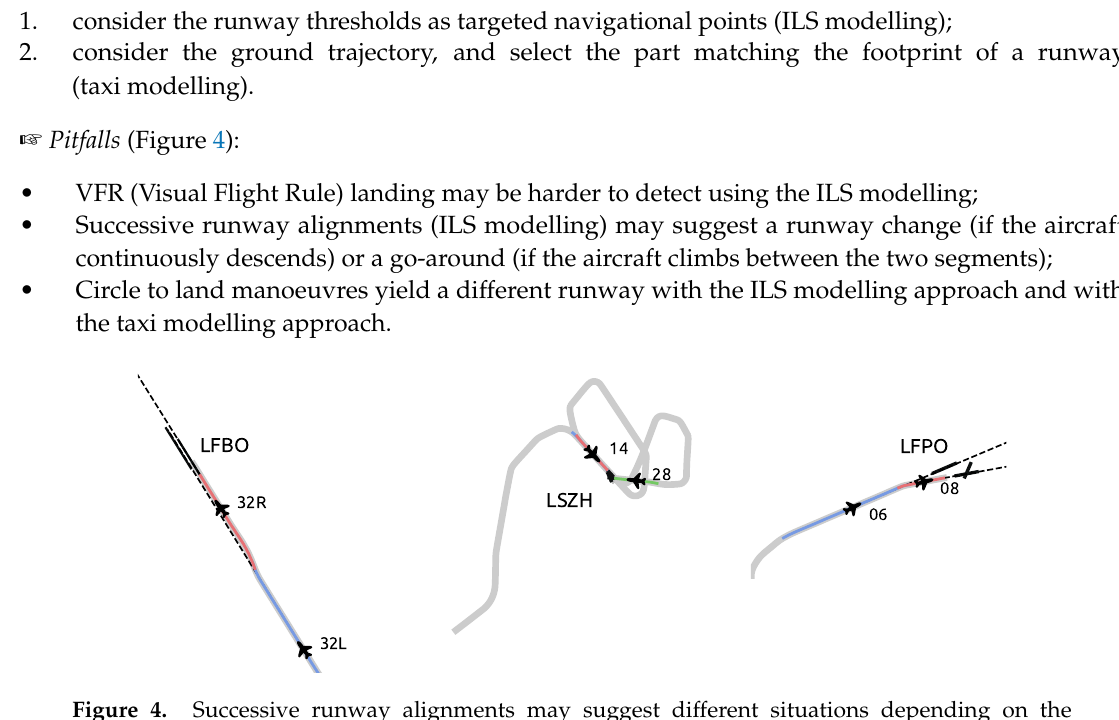
Figure 4. Successive runway alignments may suggest different situations depending on the configuration of the airport and on the vertical speed: runway change with parallel runways at Toulouse LFBO airport on the left, failed landing attempts with go-around at Zürich LSZH airport in the middle or circle to land manoeuvres at Paris–Orly LFPO